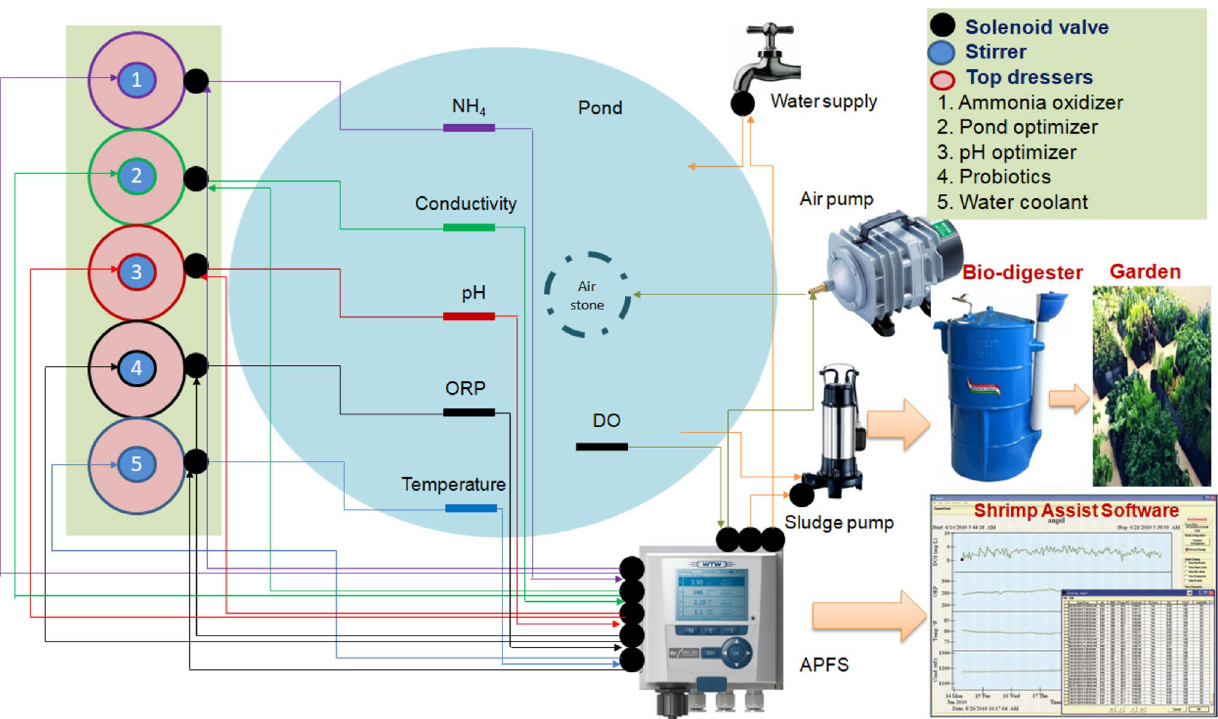
Fig. 4 The proposed model for a top-dressing automation system for Biofloc production of